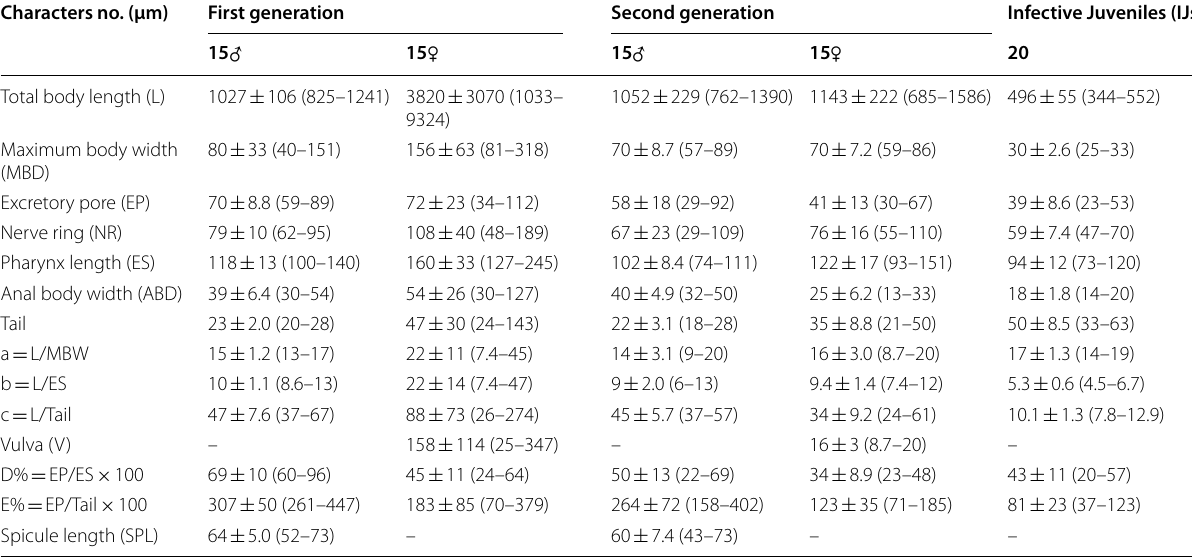
Table 2 Morphometric of all generations of isolate Steinernema abbasi CS-39. All measurements are in micrometer (µm) mean standard deviation (range) ±